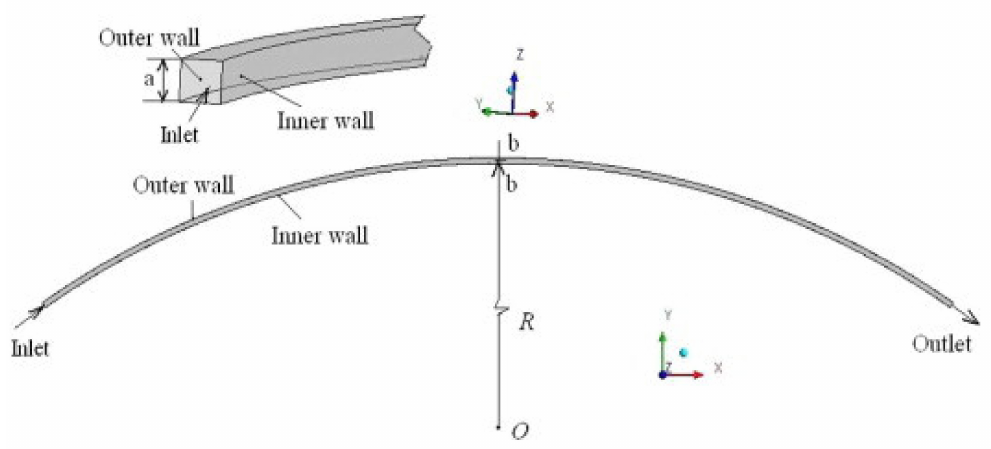
Figure 6. Curved duct with square cross-sectional area [78] © Elsevier,